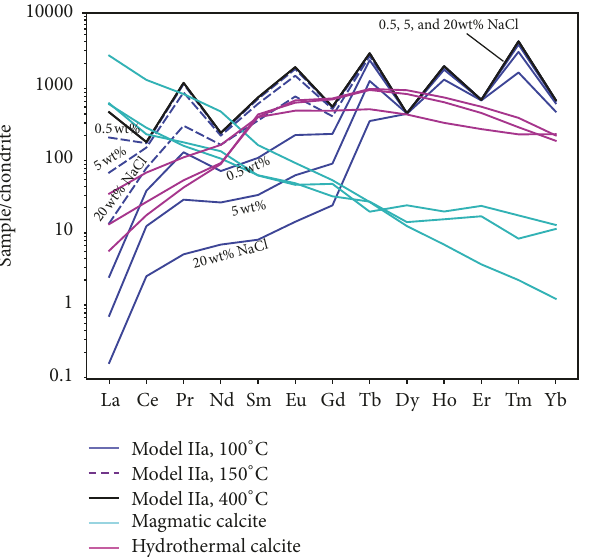
Figure 6: Chondrite-normalized REE profiles of calcite simulated in this study compared to natural calcite compositions from the Bear Lodge, WY, and Kerimasi, Tanzania, carbonatite REE deposits. The middle (M)REE- and HREE-enriched profiles are interpreted ashydrothermalcalciteandtheLREE-enrichedprofilesasmagmatic calcite [31, 32]. Chondrite data are from McDonough and Sun (1995)